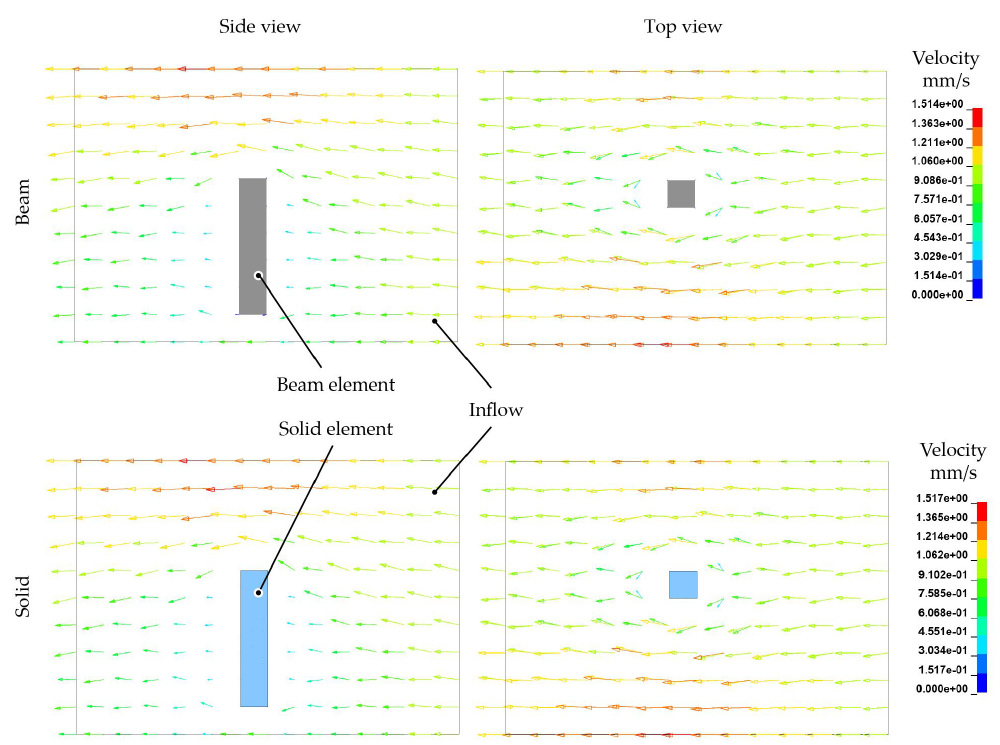
Figure 13. Similar flow behaviour around structures modelled with beam and solid elements (ALE method).